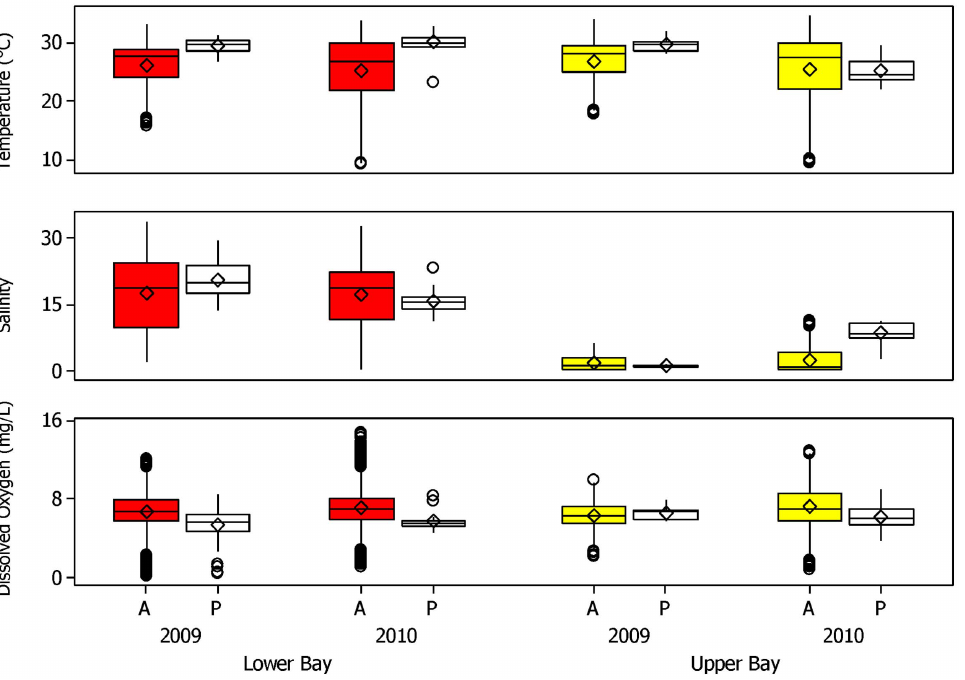
Figure 5. Bull shark presence as a function of hydrographic data. Box and whisker plots (median, interquartile range) of temperature, salinity and dissolved oxygen are shown during periods of telemetered bull shark absence (A) and presence (P) in the lower (red) and upper (yellow) portions of Mobile Bay. Mean values are shown with diamonds, and circles indicate outliers.